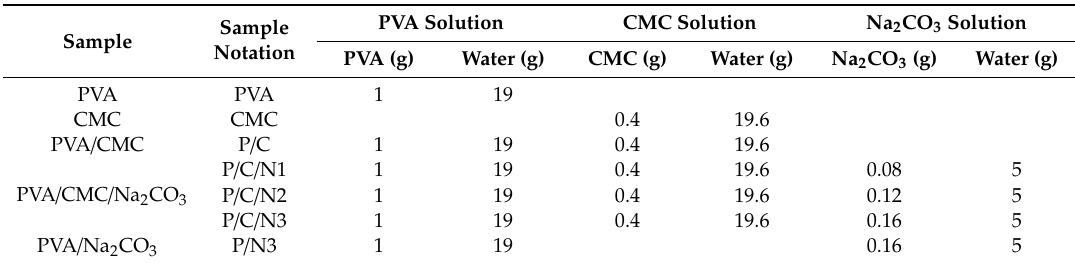
Table 1. The formulations and abbreviations of the samples. PVA—polyvinyl alcohol; CMC—carboxyl methyl cellulose